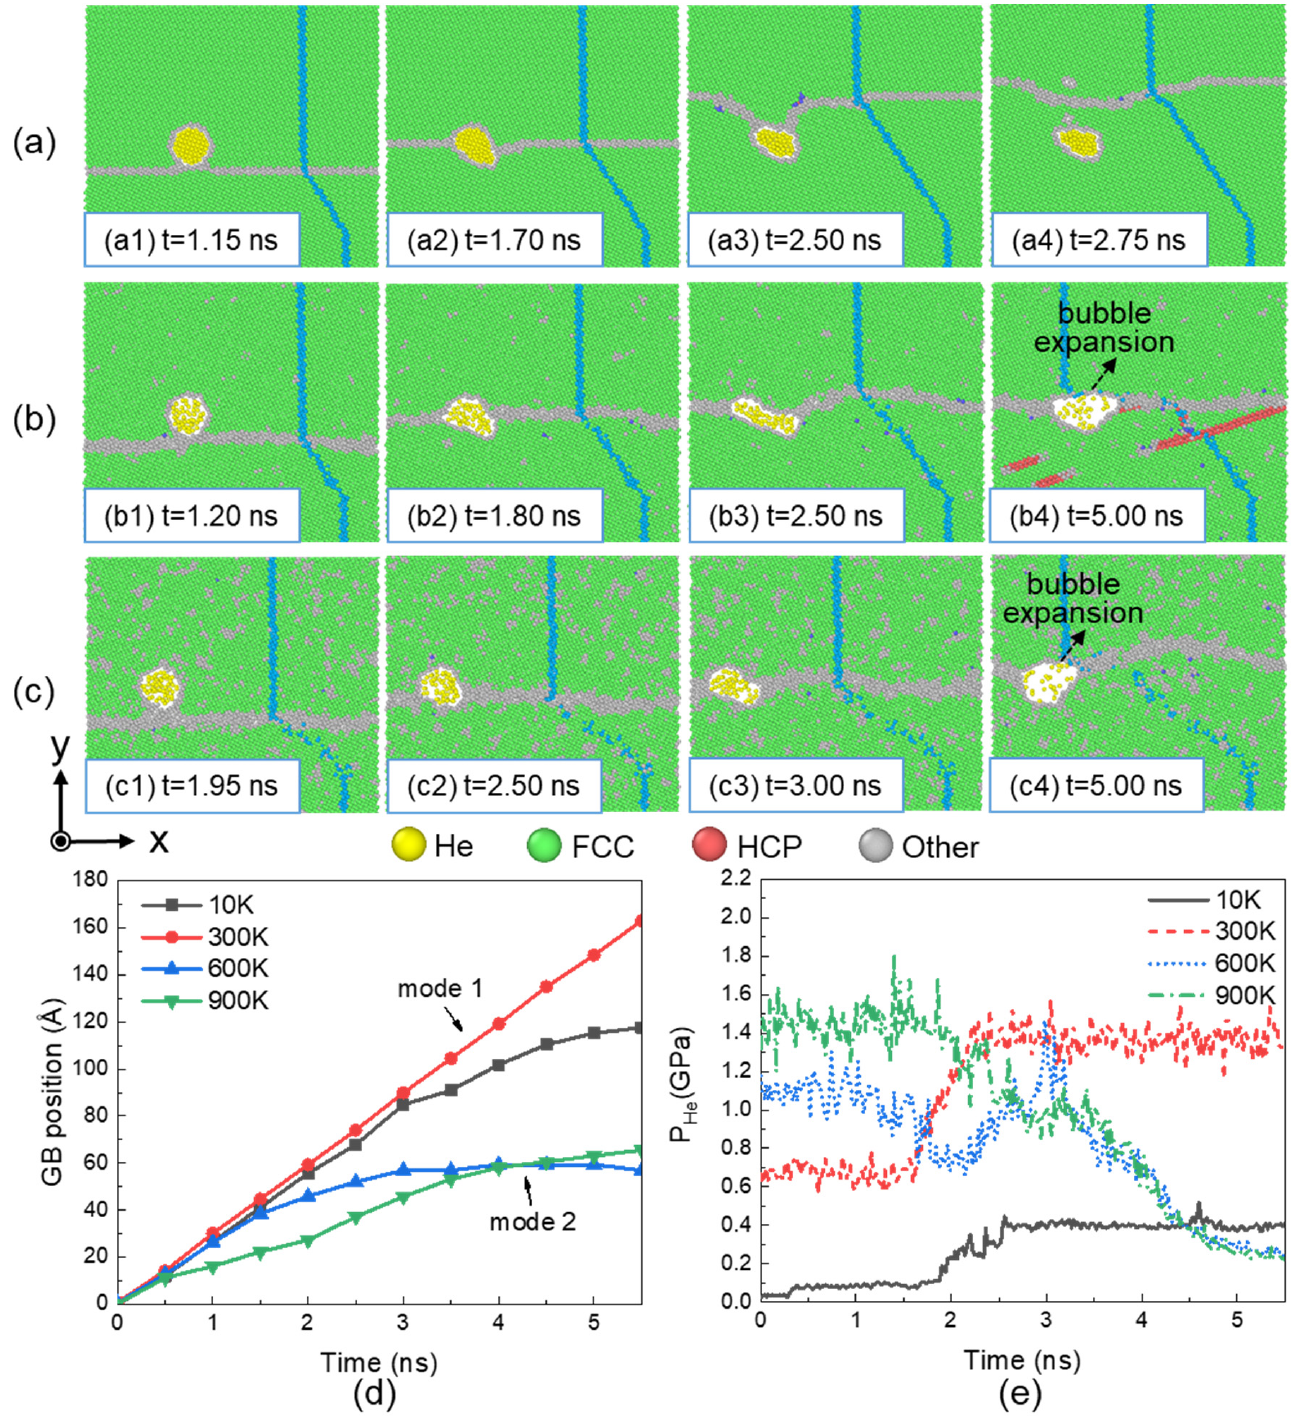
Figure 6. Snapshots of the interaction process between GB and He bubble for samples with different T 0 at R He/V = 0.5 and D 0 = 2 nm, and the corresponding evolution of GB position and He bubble pressure. ( a – c ) Cross-sectional view of the dynamic interaction process: ( a ) 10 K; ( b ) 600 K; ( c ) 900 K; ( d ) GB position; ( e ) He-bubble pressure.